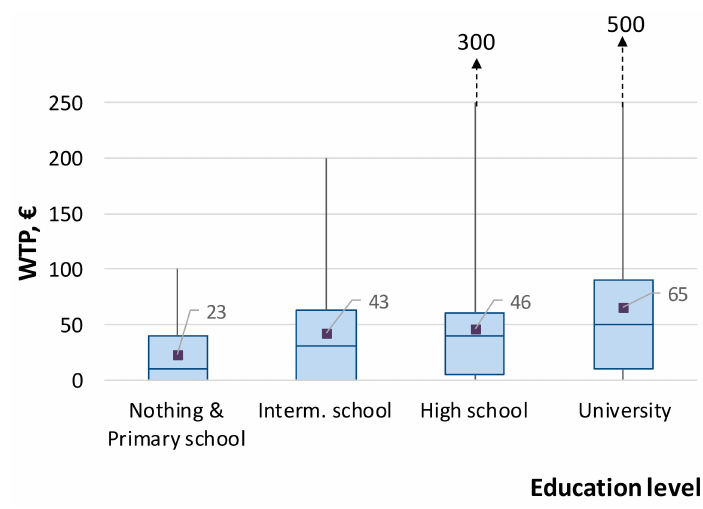
Figure 10. Distribution of WTP with respect to education level.